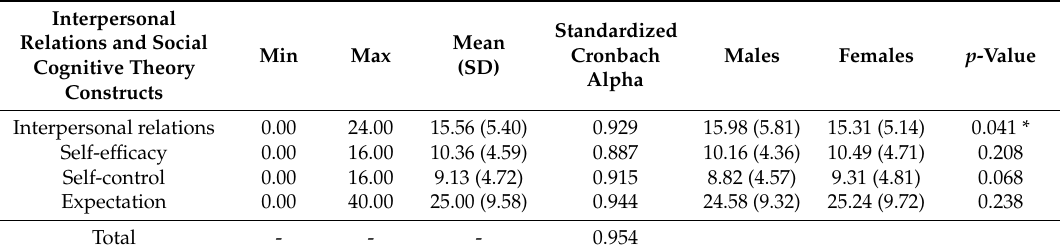
Table 4. Interpersonal relations and social cognitive theory constructs among undergraduate students in Chongqing, China.